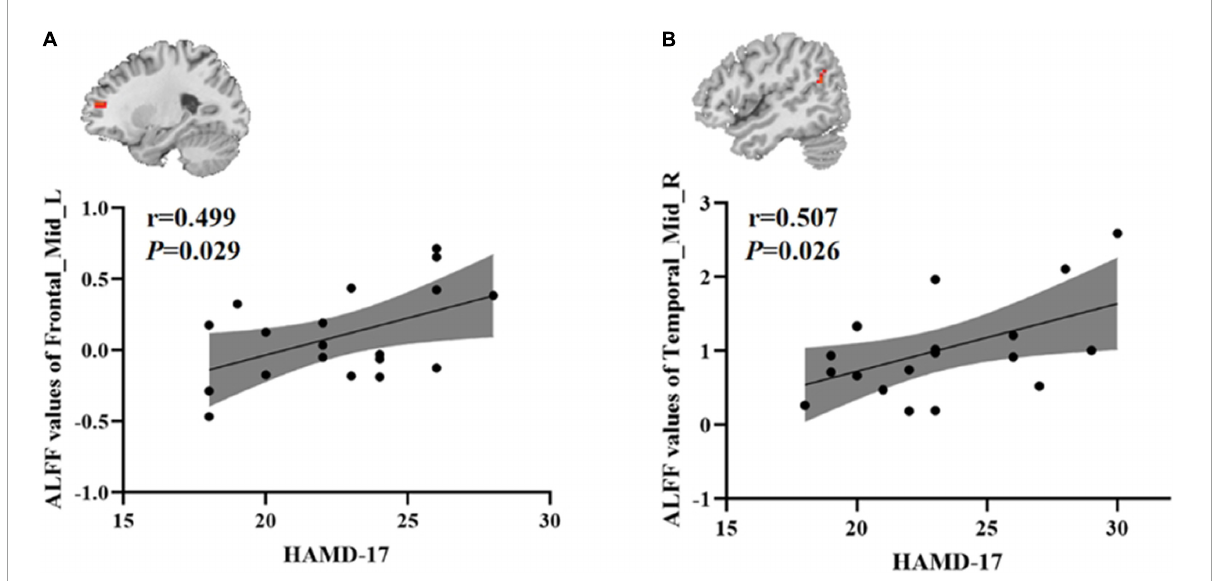
FIGURE3 Positive correlation between the ALFF values of abnormal brain regions and the HAMD-17 scores: (A) ALFF values in the younger TRD group; (B) ALFF values in the older TRD group; Frontal_Mid_L, Left middle frontal gyrus; Temporal_Mid_R, Right middle temporal gyrus; ALFF, amplitude of low-frequency fluctuations; HAMD-17, 17-item Hamilton Rating Scale for